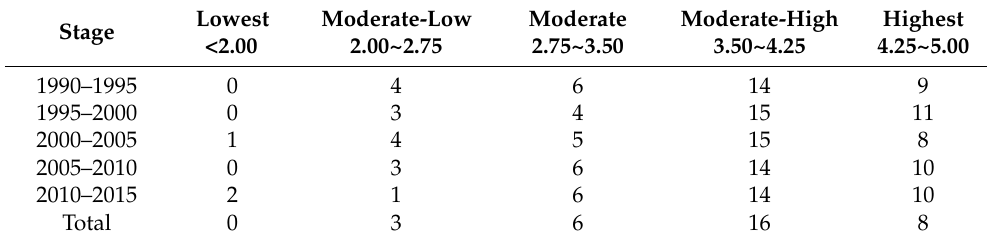
Table 1. Numbers of units with different ecological stress levels in each